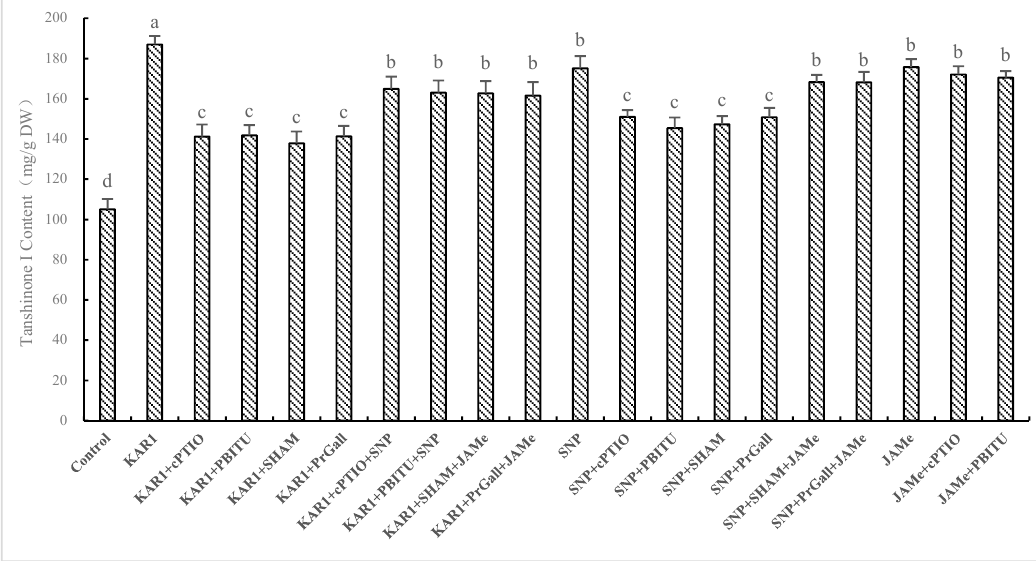
Figure 6. Effects of inhibitors on KAR 1 -induced T-I production of S. miltiorrhiza hairy root. The root treated with KAR 1 of, and inhibitors were harvested at 24 h after KAR 1 and T-I production was then determined. Inhibitors were pretreated 1 h before KAR 1 . The control received vehicle solvent only. Data are means of three replicates ± SD. Different letters indicate significantly different values according to one-way ANOVA followed by Tukey’s test ( p < 0.05).